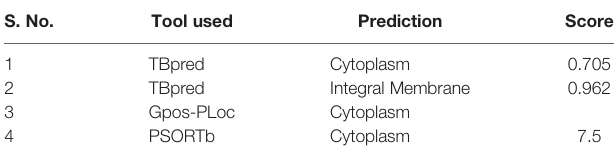
TABLE 1 | Prediction of subcellular localization by in silico analysis of Rv1509 protein. S.